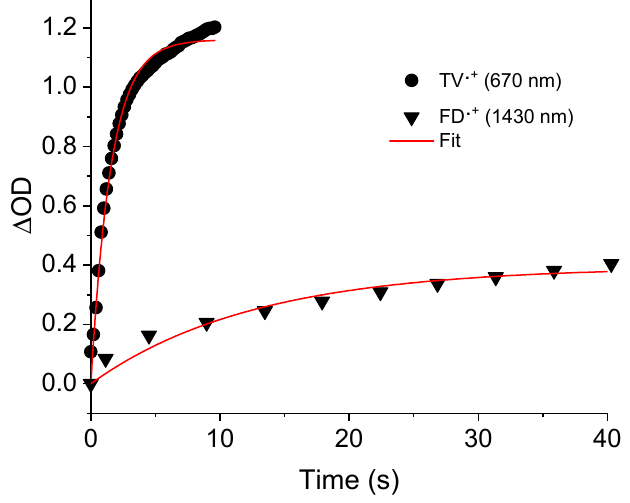
Figure 4. Optical density changes vs. time at 670 nm and 1430 nm of the devices with TV / Fc and TV / FD, respectively. The continuous lines are the best fitting curves obtained by the Equation (6). Table 1. Fitting parameters for the coloration kinetics at 670 nm and 1430 nm.